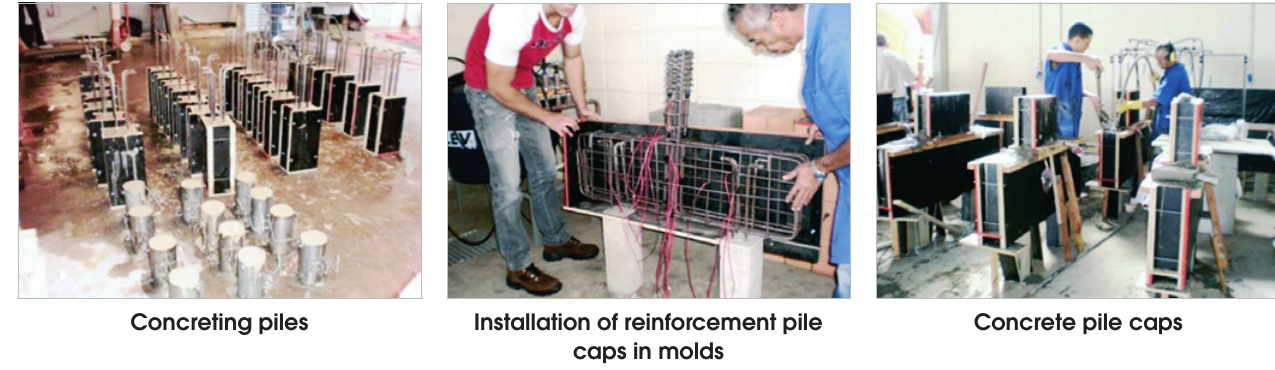
Stages of construction of experimental models